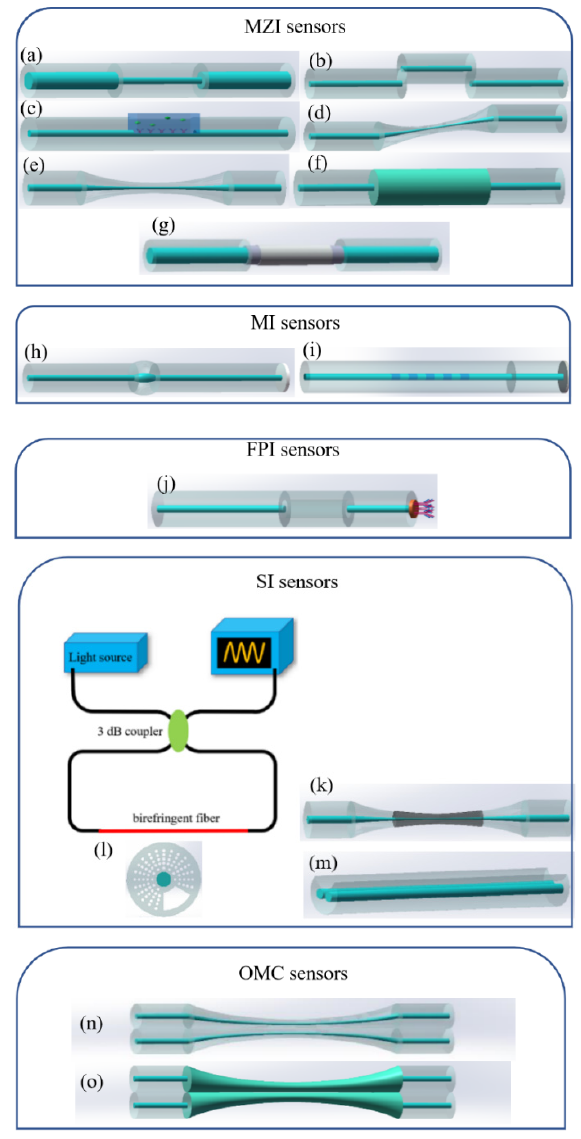
Figure 6. The schematic diagrams of ( a – g ) the MZI sensors, ( h – i ) MI sensors, ( j ) FPI sensors, ( k – m ) SI sensors, and ( n – o ) OMC sensors.